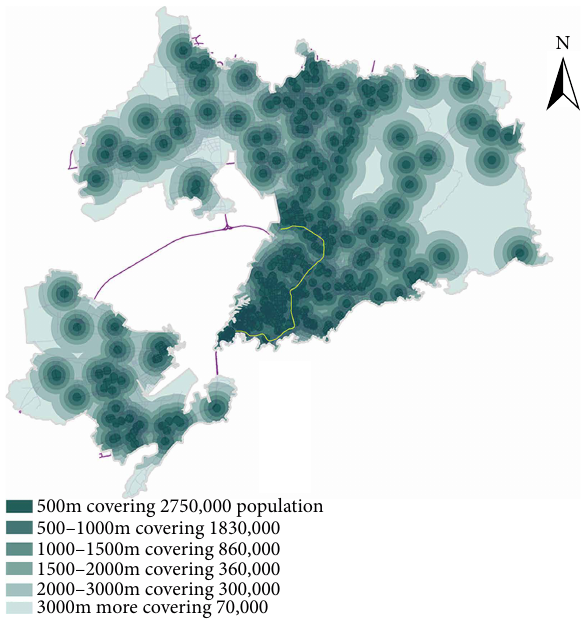
Figure 22: Population coverage of schools.